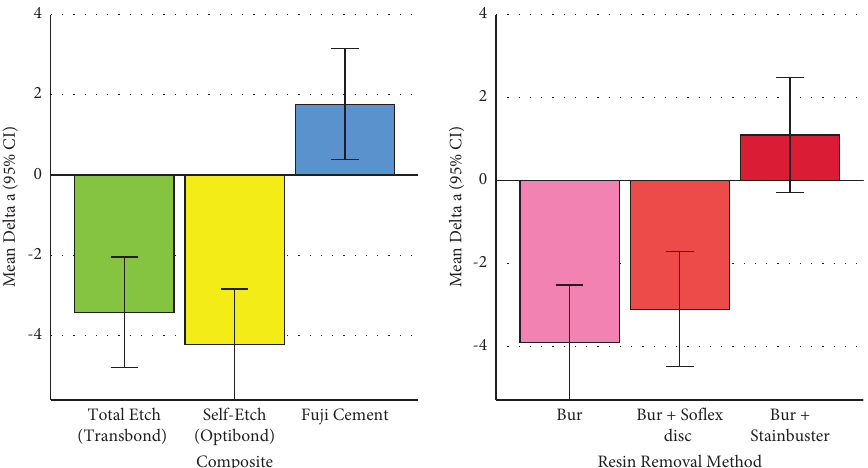
Figure 1: Means (and 95% CIs) for the Δ a parameter in 3 composites ( n � 3 × 30) and 3 adhesive removal methods ( n � 3 × 30). Positive values indicate shades of red, while negative values indicate shades of